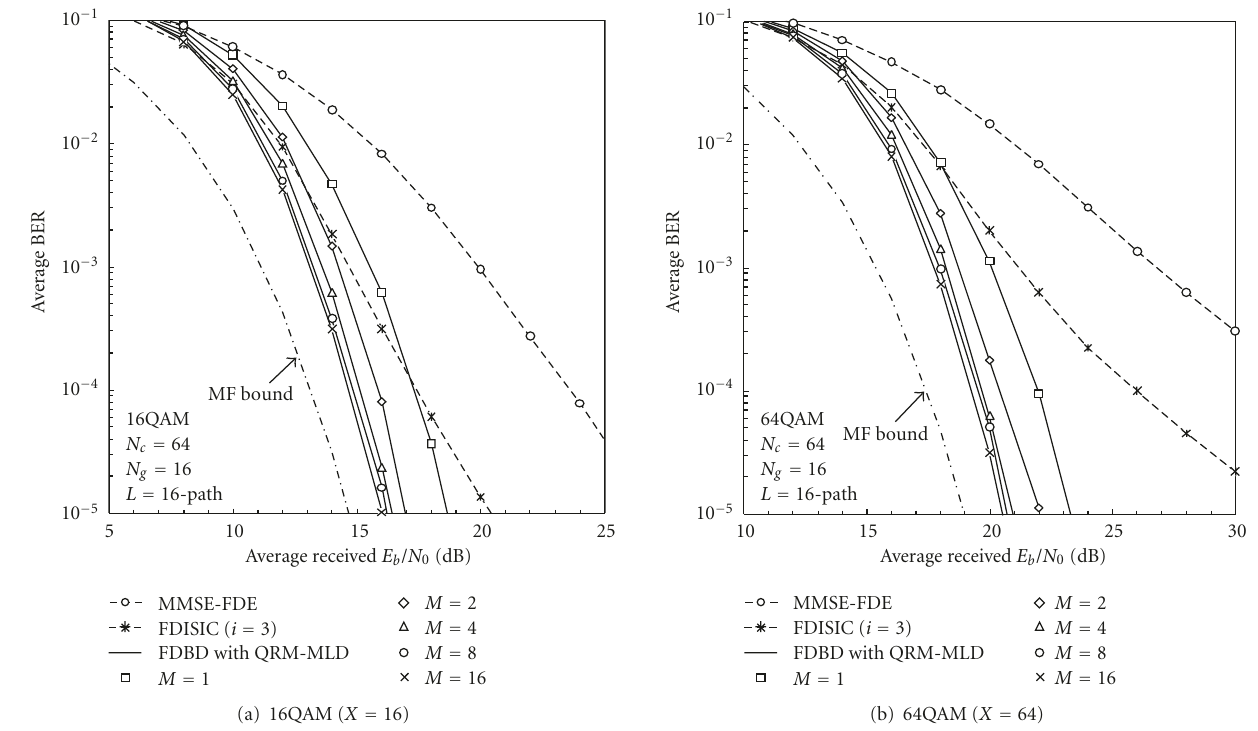
Figure 10: BER performance comparison between FDBD with QRM-MLD, MMSE-FDE, and FDISIC in uncoded TA-SC.